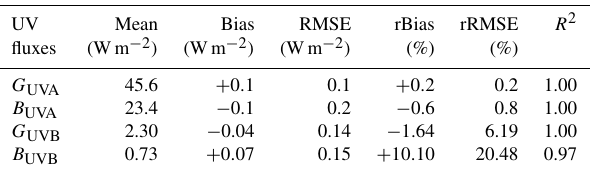
Table 4. Statistical indicators of the performances of the proposed technique for estimating UV